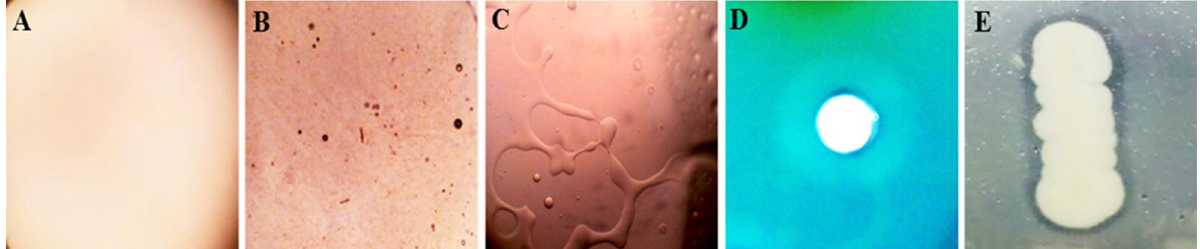
Figure 1. Biosurfactant screening assays ( A ) Oil collapsation test—Control oil droplets without biosurfactant treatment, ( B ) droplet collapsation of oil after the addition of biosurfactant at 20 s, ( C ) at 40 s (10X magnification), ( D ) CTAB- methylene blue zone of biosurfactant production, ( E ) Hydrolysis of